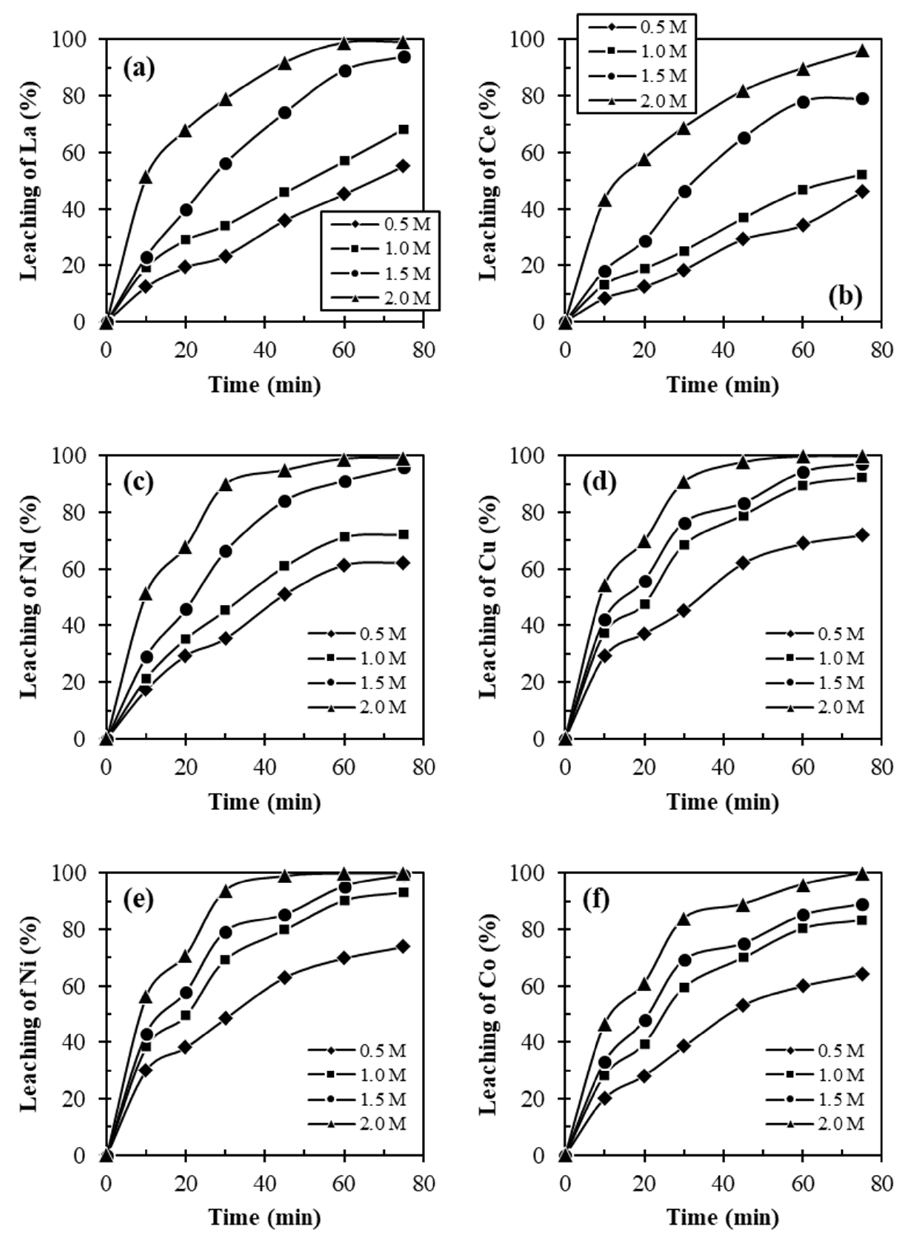
Figure 5. Effect of acid concentration on leaching of ( a ) La, ( b ) Ce, ( c ) Nd, ( d ) Cu, ( e ) Ni and ( f ) Co from black powder of spent NiMH battery of electric vehicle [Solid: black powder; liquid: 0.5–2.0 M H 2 SO 4 ; additive: 10% H 2 O 2 ( v / v ); temperature: 75 °C; pulp density 100 g/L; time: 75 min].